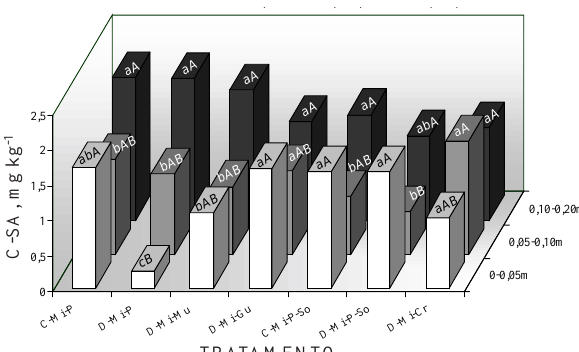
Figura 4. Teores de carbono na fração ácido húmico em um Latossolo Roxo com milho sob diferentes sistemas de produção por seis anos. C = sistema de semeadura convencional; D = sistema plantio direto; Mi = milho semeado no verão; So = soja semeada no verão; P = pousio no inverno; Mu = semeadura de mucuna preta no inverno; Gu = semeadura de feijão guandu no inverno; Cr = semeadura de crotalária no inverno. Médias seguidas de mesma letra não diferem entre si pelo Teste de Tukey, a 5 %. Letras minúsculas comparam médias dispostas na vertical. Letras maiúsculas comparam médias dispostas na